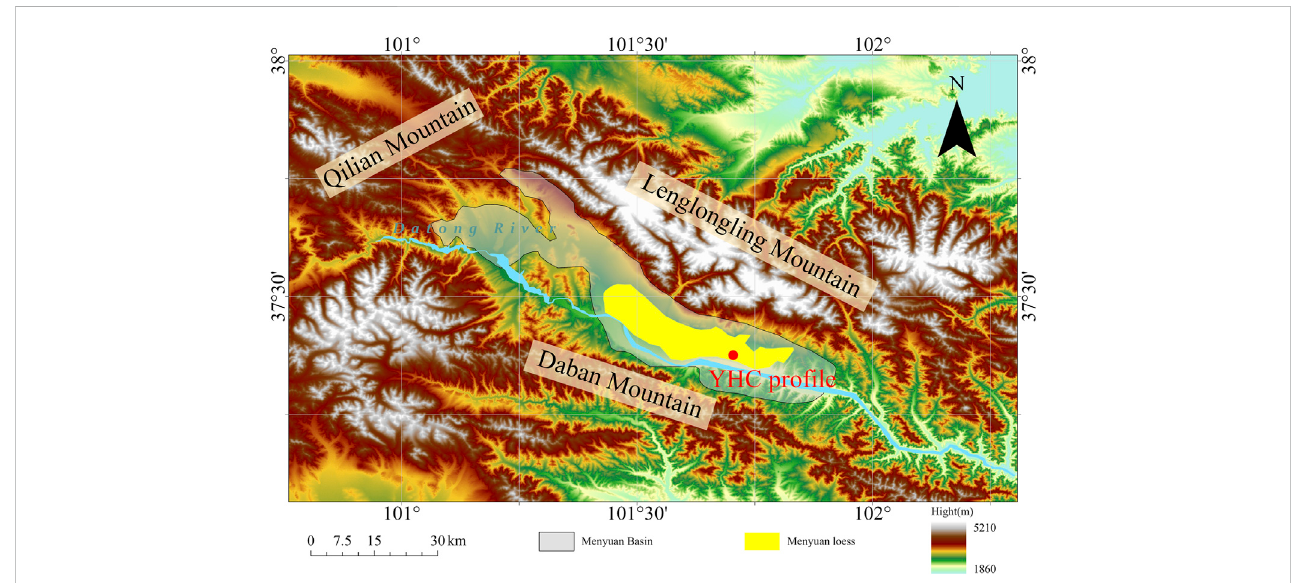
Digital elevation model (DEM) of the Menyuan Basin and location of the YHC pro fi le. DEM data from